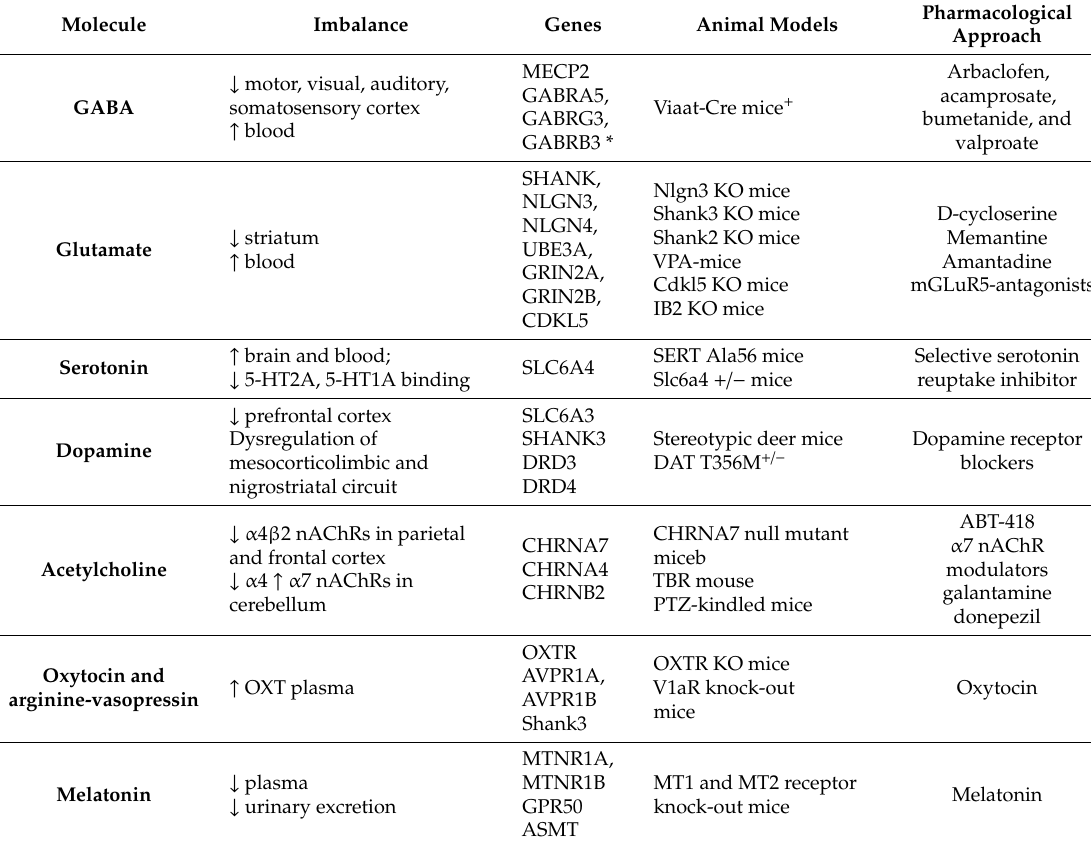
Table 1. Main neurochemical